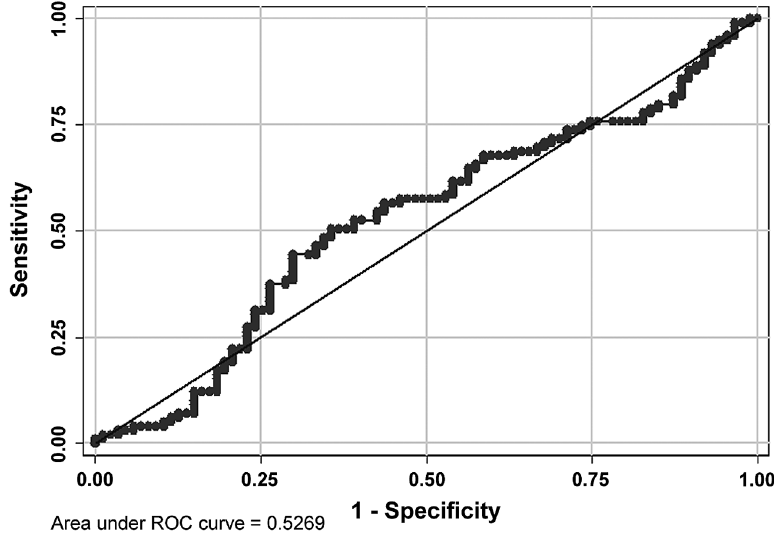
Figure 2 – Receiver operating characteristic (ROC) curves for vascular endothelial growth factor (VEGF) serum levels as a test for diagnosis prostate carcinoma using the biopsy results as the gold